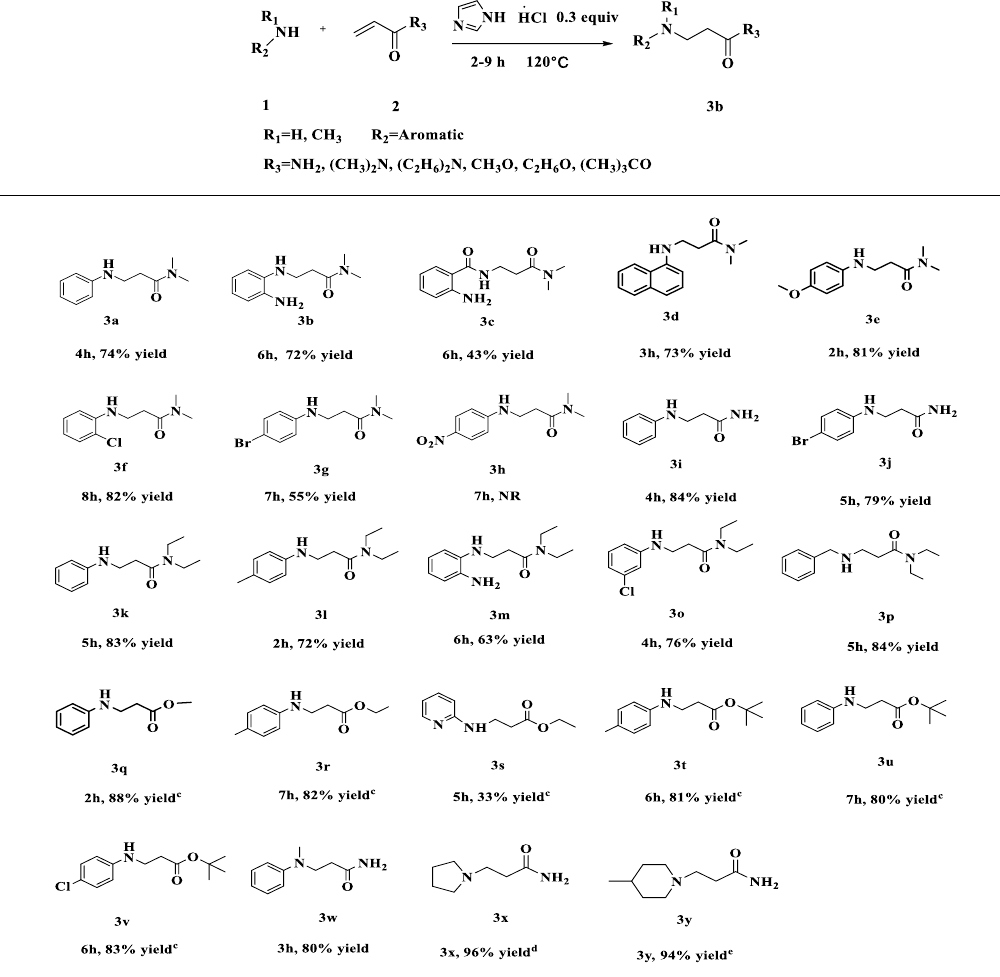
Molecules 2019 , 24 ,